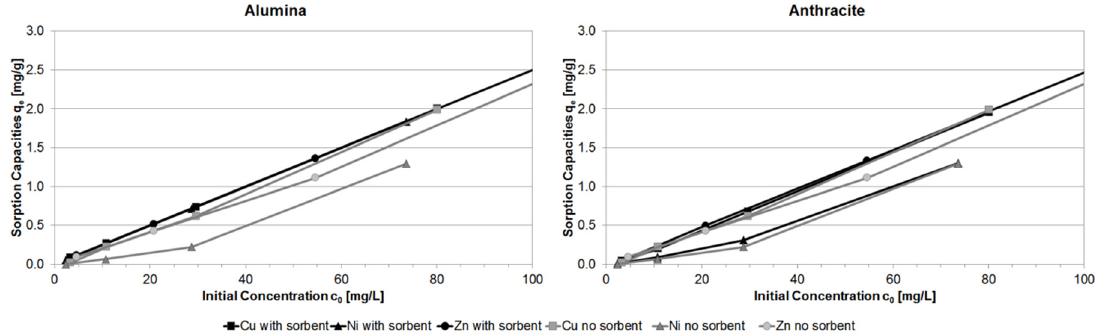
Figure 3. Influence of the filtration process at pH 7 for experiments using a buffer and a rotary shaker: heavy metal removal for different initial concentrations for two sorbents and for the same initial concentrations without any sorbent (metal no